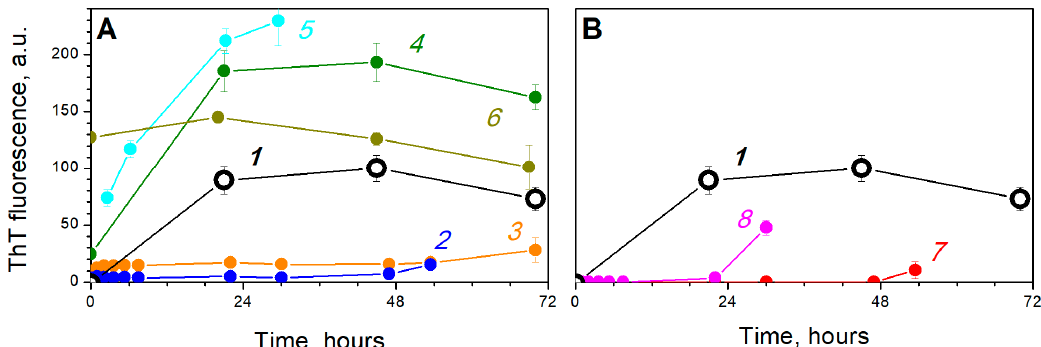
Figure 1. Kinetics of fibril formation detected by thioflavin T (ThT) fluorescence assay. ( A ) Free alpha-synuclein (1), alpha-synuclein in the presence of 5 mM poly(styrene sulfonate) (PSS) (2), poly(anethole sulfate) (PAS) (3), dextran sulfate (DS) (4), poly(vinyl sulfate) (PVS) (5) and polymethacrylic acid (PMA) (6). ( B ) Free alpha-synuclein (1), alpha-synuclein in the presence of 5 mM poly(N-ethyl-4-vinylpyridinium) bromide (PEVP) (7) and PEVP-50% (8). Fluorescence intensity is presented as a percentage of the maximum for free alpha-synuclein. The values of ThT fluorescence in the presence of polymers without protein are subtracted.